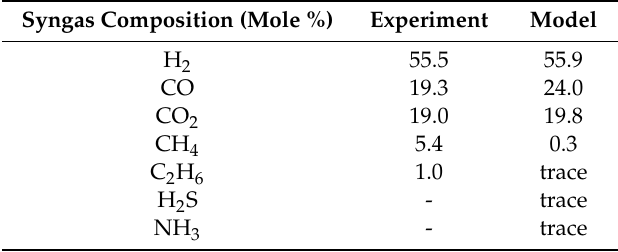
Table 5. Comparison between experimental and simulated results of gasification